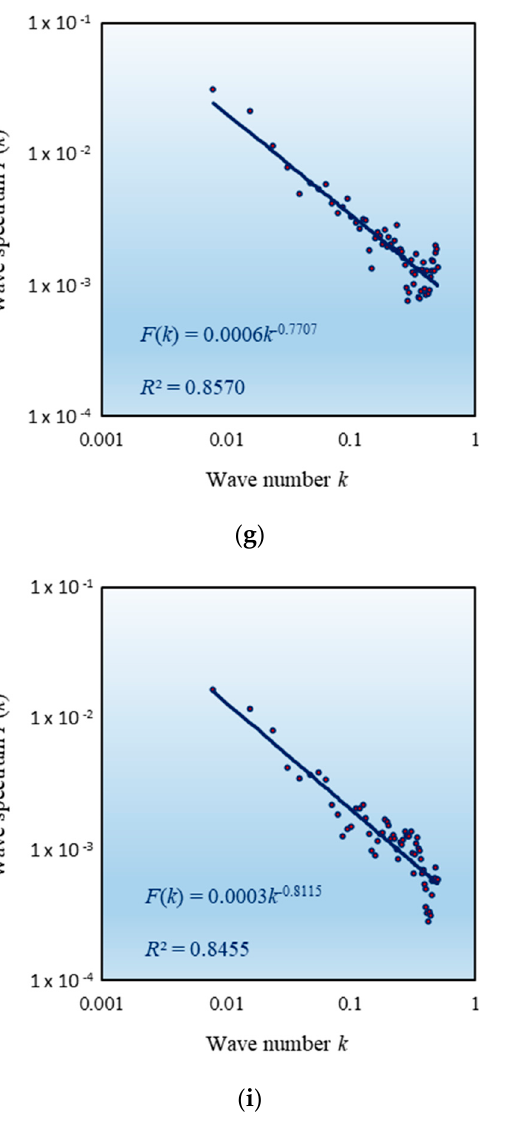
Figure 5. The wave-spectrum scaling relations between wave numbers and wave spectrums (2016). ( a ) Beijing; ( b ) Tianjin; ( c ) Guangzhou; ( d ) Shenzhen; ( e ) Wuhan; ( f ) Nanjing; ( g ) Shanghai; ( h ) Hangzhou; ( i ) Chongqing; ( j ) Chengdu. Note: All the spectral exponents were estimated by Equation (17), which is based on Equation (6). By using Equation (8), we can easily turn the spectral exponent values into fractal dimension values.